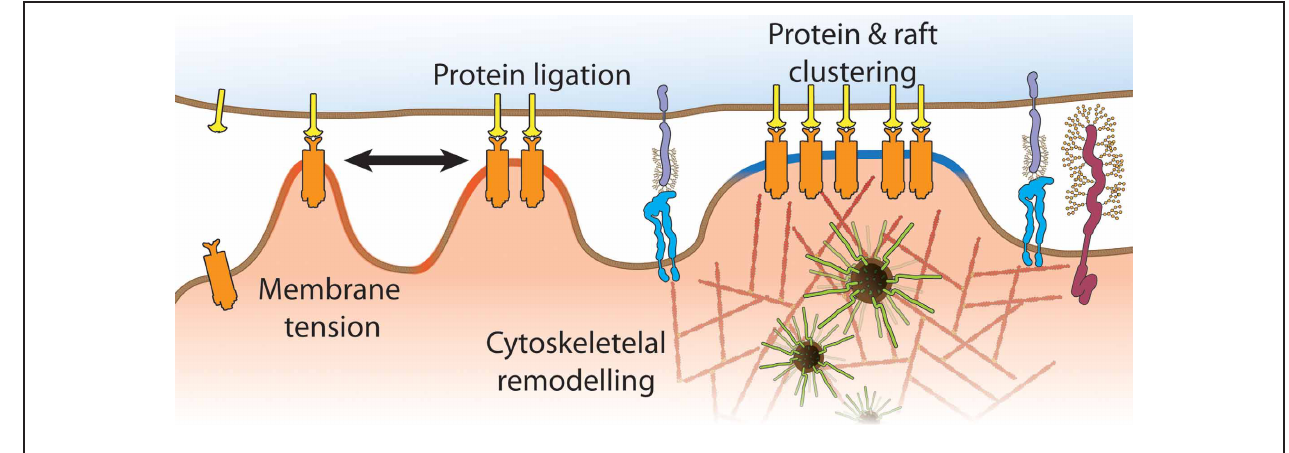
regions), variable inter-membrane distances across the immunologicalsynapse, membranecompartmentalizationbycortical actin and positioning and abundance of lipid domains (blue